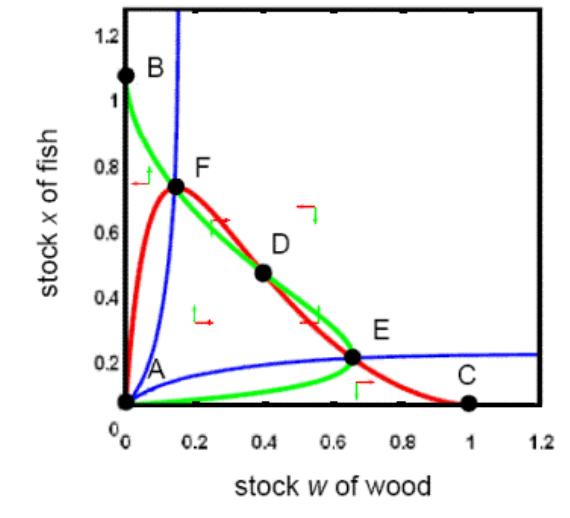
Again, the green line is the isocline for dx / dt = 0, the red line is the isocline for dw / dt = 0. Left (right) of the dx / dt = 0-isocline the dynamics are characterized by dx / dt > 0 (< 0). Likewise, below (above) the dw / dt = 0-isocline the dynamics are characterized by dw / dt > 0 (< 0). In each segment of state space, the green and red arrows indicate this direction of dynamics. Although A ( x = w = 0 ) is still an unstable equilibrium, B ( x = 1, w = 0 ) and C ( x = 0, w = 1 ) are now locally stable equilibria. D is still a stable equilibrium, but it is now only locally stable. In addition, there are two new equilibria, E and F, that are locally saddlepoint-stable. The basins of attraction associated with the stable equilibria are as follows: the area northwest of the upper saddlepath (for B), the upper saddlepath (for F), the area in between the two saddlepaths (for D), the lower saddlepath (for E), and the area southeast of the lower saddlepath (for